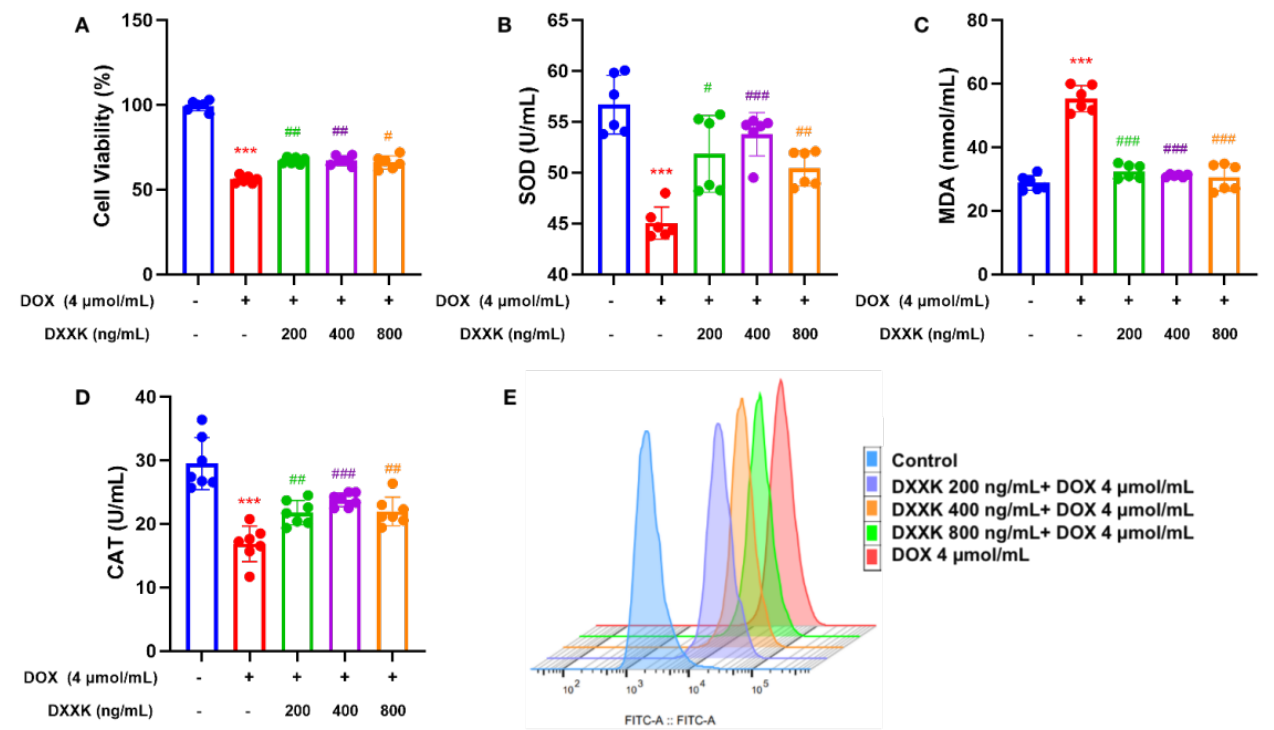
Figure 3. DXXK can protect H9c2 cells from DOX-induced injury. ( A ) Cell viability; ( B ) SOD; ( C ) MDA; ( D ) CAT; ( E ) ROS. *** p < 0.001 compared with the control group. # p < 0.05, ## p < 0.01 and ### p < 0.0001 compared with the DOX group. ” + ” indicates that drugs are added, and “ - ” indicates that drugs are not added.